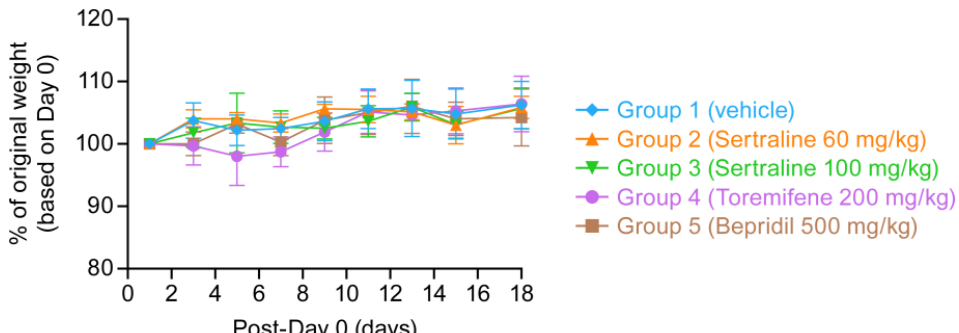
Figure 5. Bepridil, sertraline and toremifene (in V8) are well-tolerated by mice. Female C57BL/6 mice (5/group) were administered the indicated doses of bepridil, sertraline and toremifene in V8 by oral gavage for 11 consecutive days. Daily average weights for 18 days for each group are shown +/− sd.